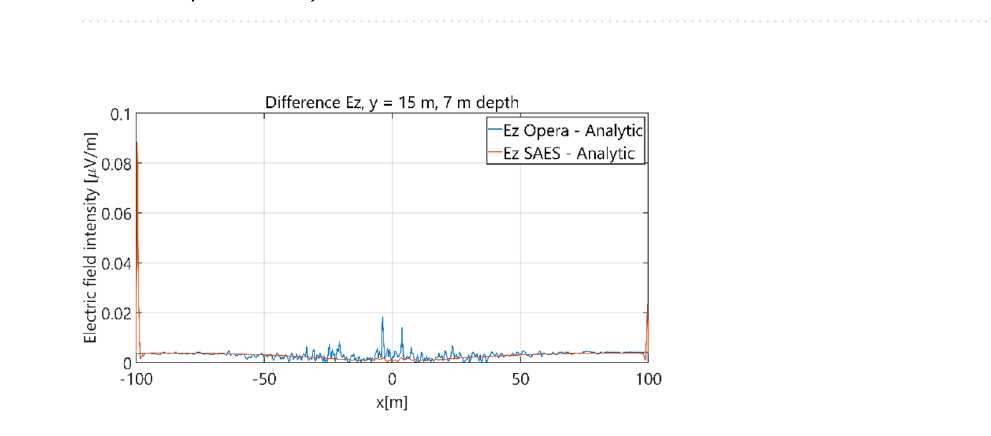
Figure 18. Distribution of differences between E z values obtained from Opera (FEM) and SAES (BEM) models and the analytical model ( y = 0 m, z = − 7 m, case I).